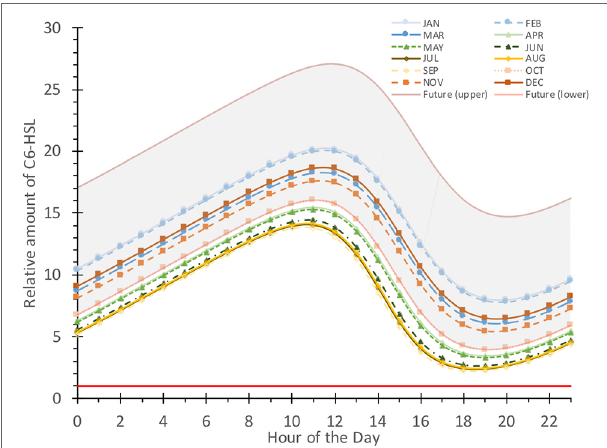
FIGURE 8 | Comparison of daily fluctuating relative C6-HSL concentration for average pH and temperature conditions each month. Relative amount is calculated based on a normalized production of 1 (red line) and current conditions within the Humber estuary for every month (averaged). The projected future range of the fluctuation is shown in grey with the upper and lower boundaries representing January (upper) and September (lower) C6-HSL amounts calculated for conditions shifted by the IPCC RCP8.5 prediction (-0.4 pH,